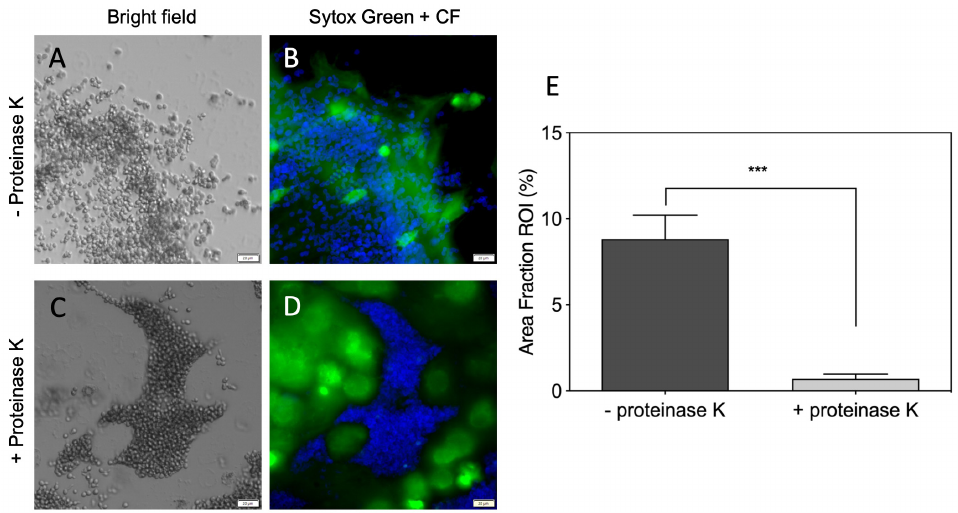
Figure 1. A significance of NET-related proteins for the interaction with C. albicans cells. In total, 2.5 × 10 5 neutrophils were stimulated for 3 h with 25 nM PMA. The extracellular DNA was stained with Sytox Green. The neutrophil proteins were eliminated from the NETs with proteinase K treatment ( C , D ). NETs which were not treated with proteinase K served as a control ( A , B ). In total, 10 6 C. albicans cells labeled with Calcofluor White (CF) were added to the released NETs (treated/not treated with proteinase K) and incubated for 1 h. A colocalization of yeast cells and NETs was assessed qualitatively using Olympus IX73 fluorescence microscopy ( A – D , cropped) and quantitatively using the Olympus cellSens imaging software. The colocalization value is presented as the percentage of the image area where the blue fluorescence channel collocates with the green one ( E ). A representative result of three independent experiments is presented. In order to assess the statistical significance between groups, an unpaired t -test was performed. The results were considered statistically significant at a p -value of <0.05 (*** p ≤ 0.0002).